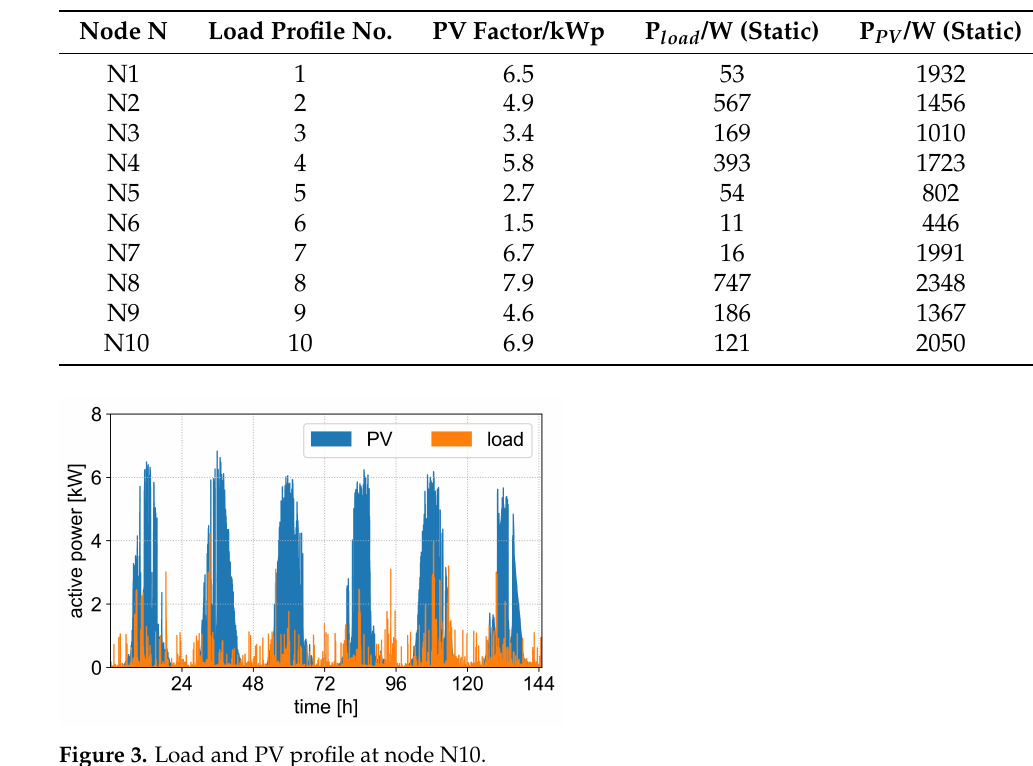
Table 2. Load and photovoltaic (PV) profile numbers and input values for the dynamic and static case studies. For the static case, the data from 21 June, 11.06 h40s was used.